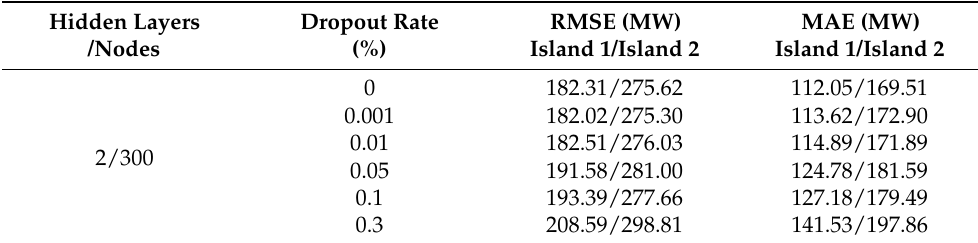
Table 2. Performance of the trained model with Dropout regularization techniques.